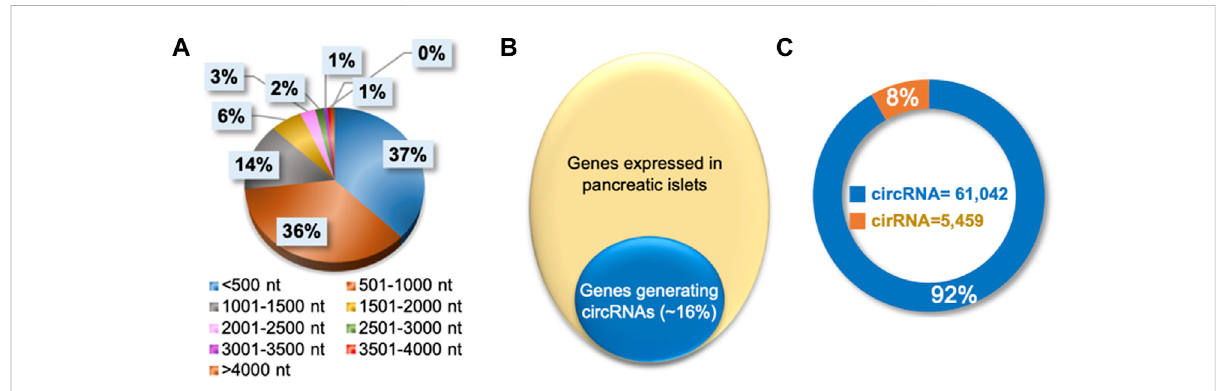
FIGURE 2 Characteristics ofcircRNAsexpressedin pancreatic islets. (A) . Percentage distribution oflength ofcircRNAsinpancreatic islets. (B) . Percentage ofgenesgenerating circRNAsinpancreaticislets. (C) . Numberofcircular RNAscategorizedas exonic circRNA orintronic ciRNAs